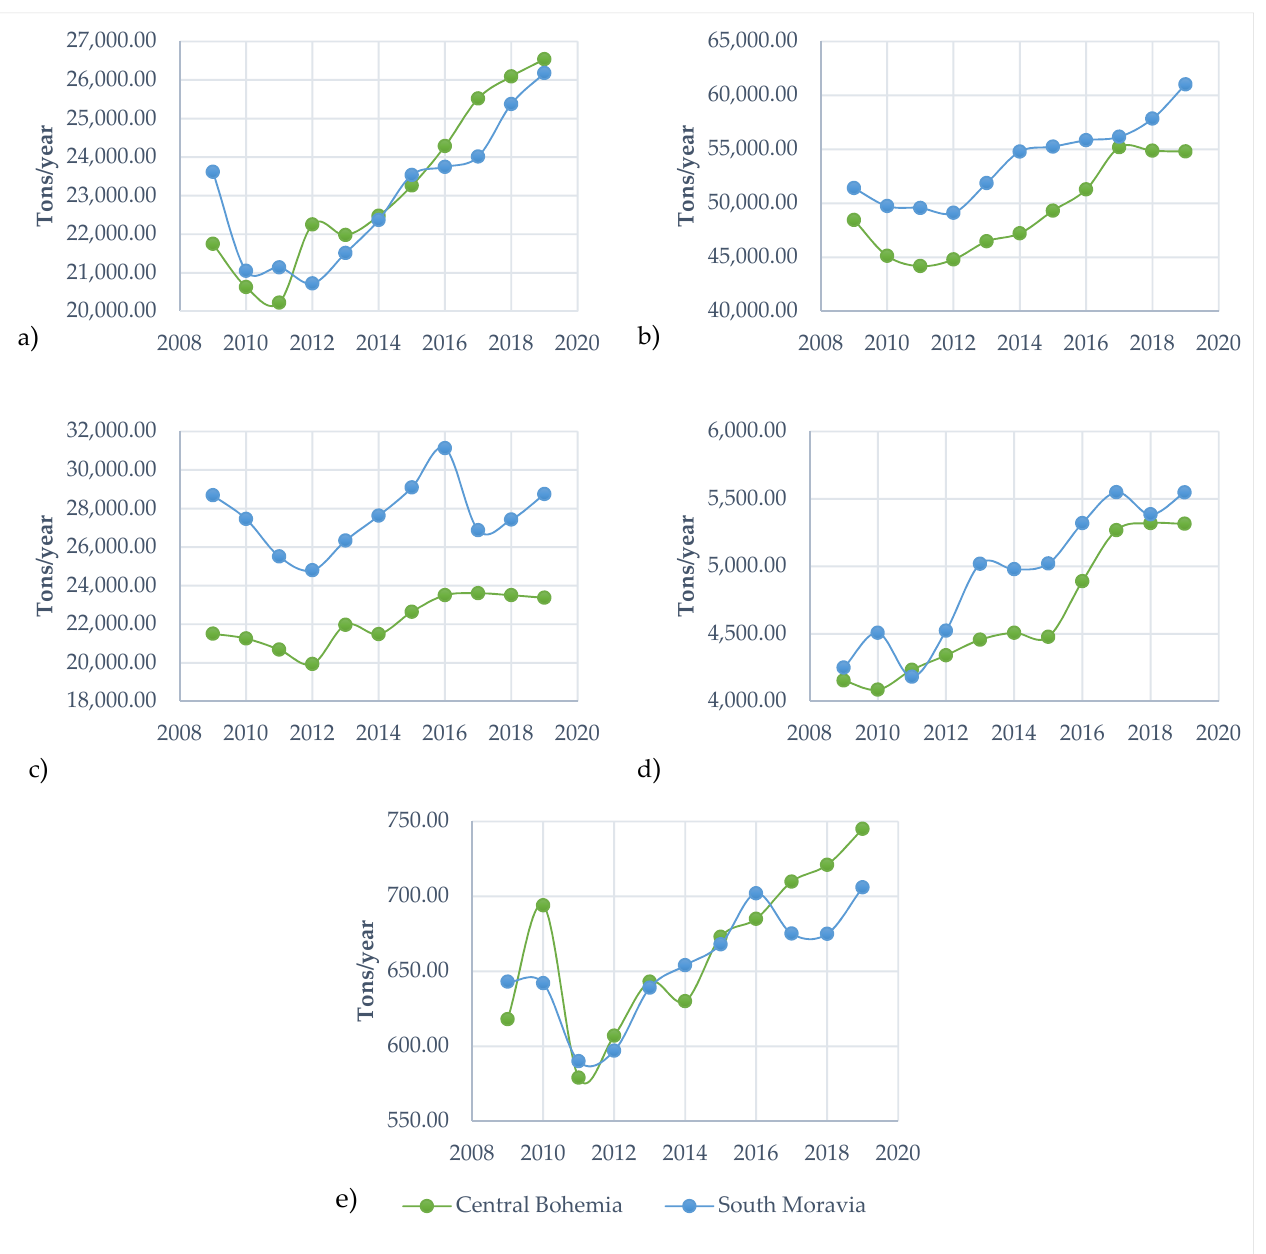
Figure 4. Load of nutrients and organic substances in inflow among measured parameters in selected regions. ( a ) BOD, ( b ) COD, ( c ) undissolved substances, ( d ) nitrogen totals, and ( e ) phosphorus totals.